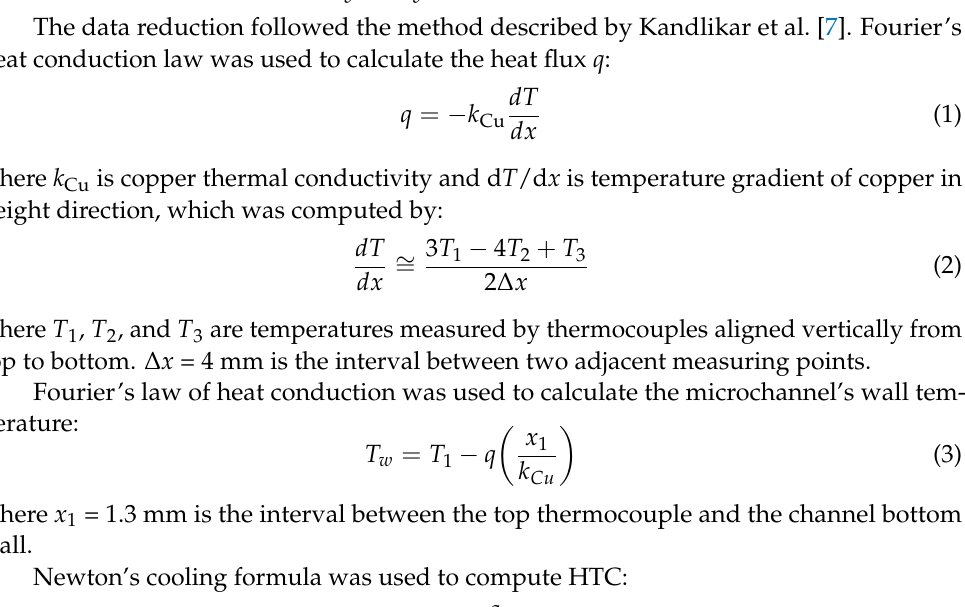
Figure 4. SEM image of the blade-like CuO nanostructures.